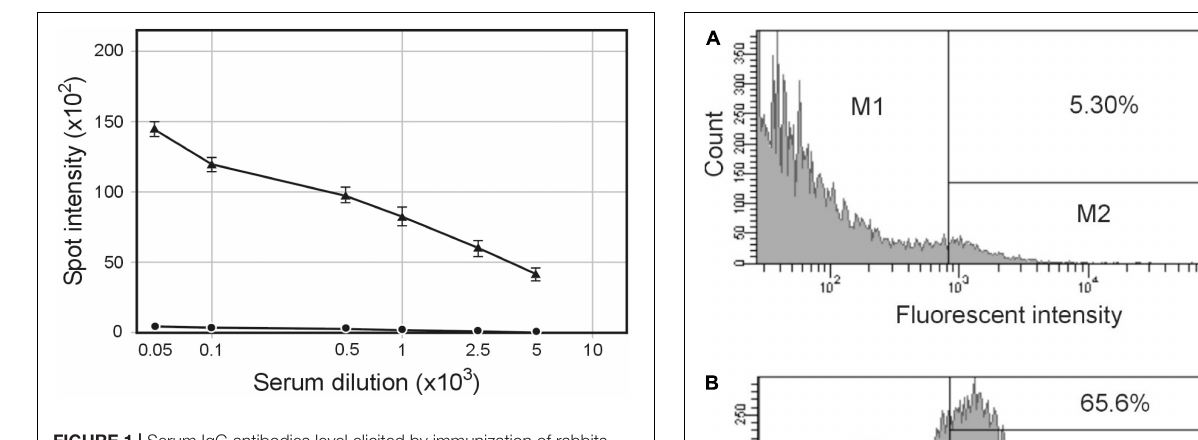
FIGURE 1 | Serum IgG antibodies level elicited by immunization of rabbits with pBSKS:: (cid:56) 6fm(ST) phagemid particles. Rabbits were immunized subcutaneously with pBSKS:: (cid:56) 6fm(ST). The sera obtained at day 28 were analyzed by quantitative dot ELISA. S. enterica cells (2 × 10 8 cells/ml) diluted in PBS were spotted on a nitrocellulose strip and allowed to dry. Binding of anti- S. enterica was detected with goat anti-rabbit IgG-alkaline phosphatase conjugate. The intensity of the color of each spot was expressed as the change of the spot intensity compared with the negative control where spotting of S. enterica was omitted. For each point, four spots were analyzed. Line: